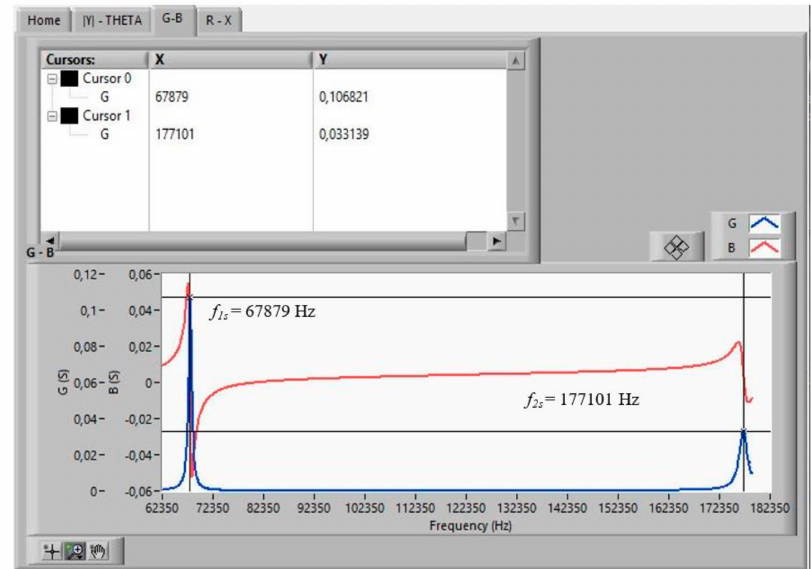
Figure 11. Searched frequencies after the automatic search step: f 1s , f 2s